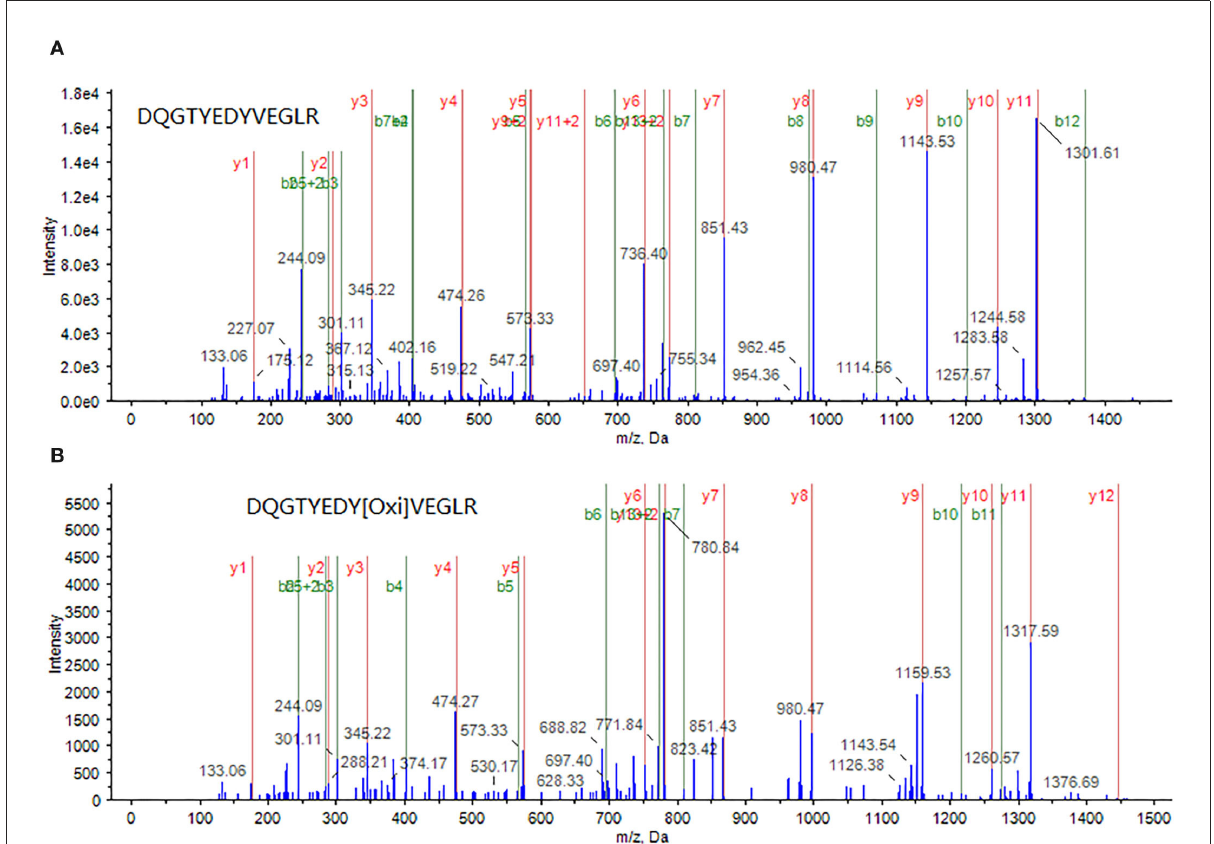
FIGURE4 A peptide DQGTYEDYVEGLR (82–94) from myosin light polypeptide 6 was identified through MS/MS spectrum of a doubly-charged peak at m/z 772.8 (A) , whereas its oxidized form, in which the tyrosine (Y) is oxidized, was identified through MS/MS spectrum of a doubly charged peak at m/z 780.7 (B)